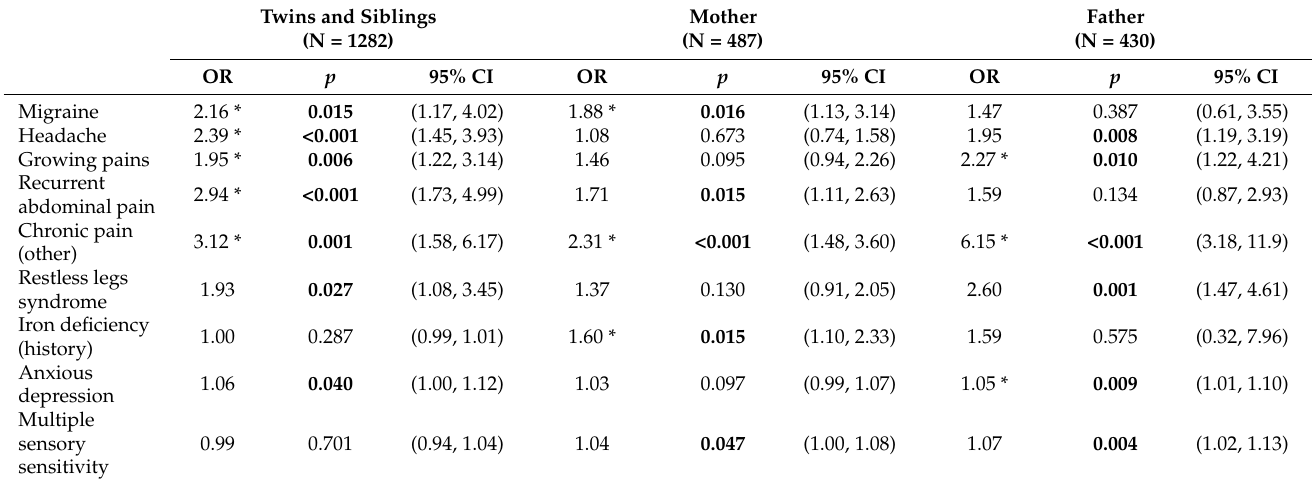
Table 7. Association between LBP (life) and primary pain conditions, chronic pain, restless legs syndrome, iron deficiency, anxious depression, multiple sensory